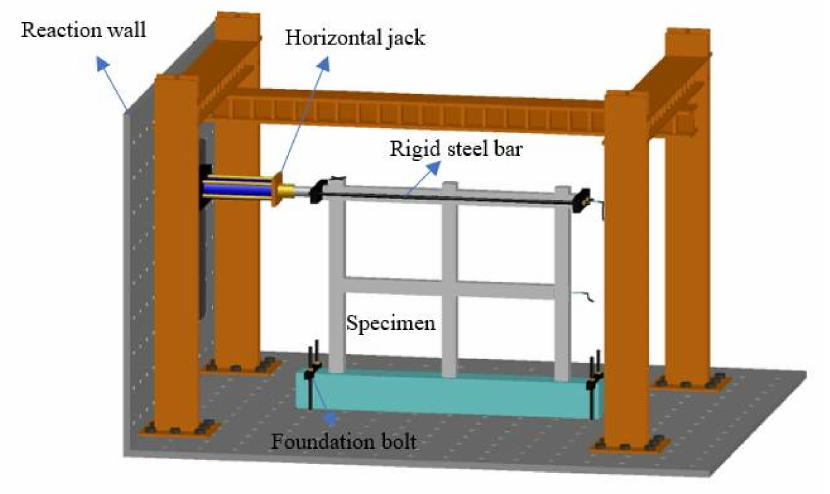
Figure 4. Schematic diagram of the test loading system.